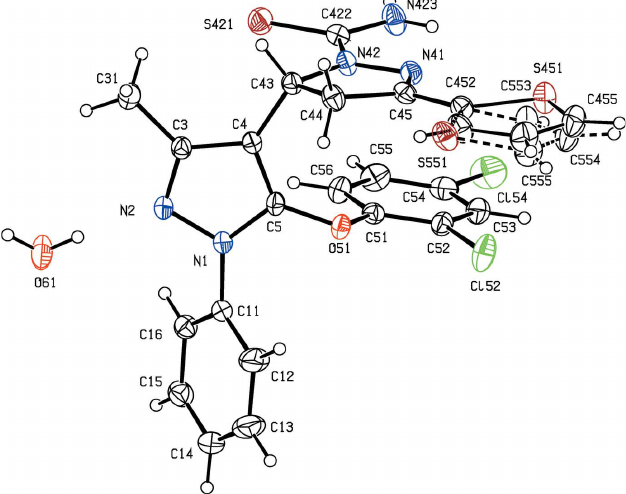
Figure 2 The structure of the independent components in compound (Ib) showing the atom-labelling scheme and the disorder in the thiophene unit, where the major disorder component is drawn using full lines and the minor disorder component is drawn using broken lines. The water molecule lies across a twofold rotation axis and the displacement ellipsoids are drawn at the 30% probability level.